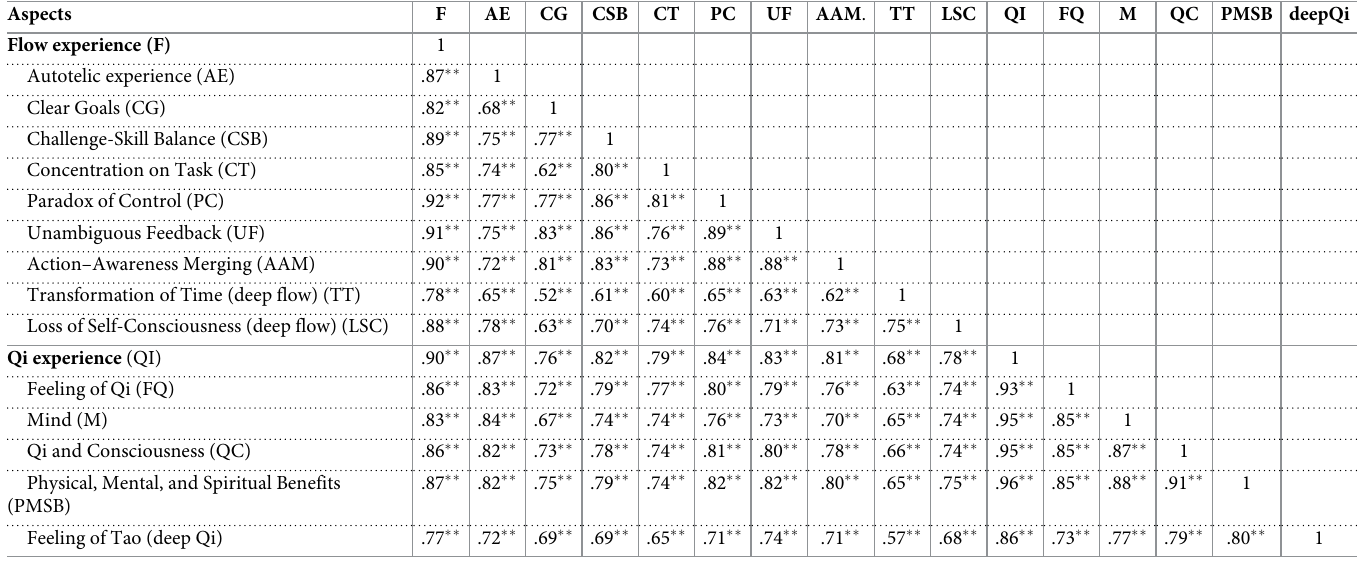
Table 5. The relationship between the flow experience and the Qi